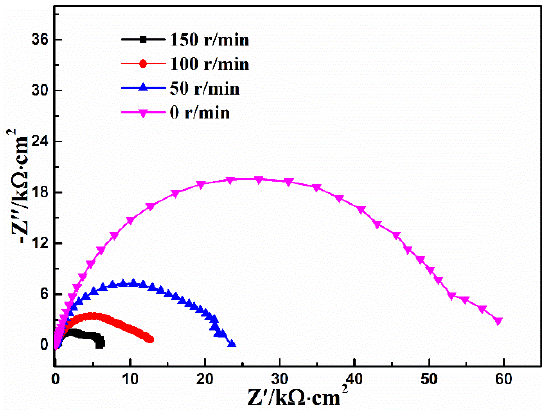
Figure 7. Experimental Nyquist plots of conversion coatings obtained from different stirring rates of Ca-P solution. Ca-P